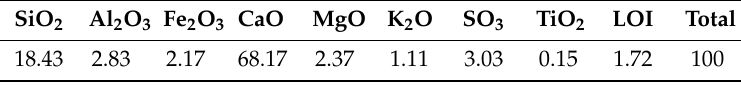
Table 1. Chemical composition (%) of ordinary Portland cement (OPC).